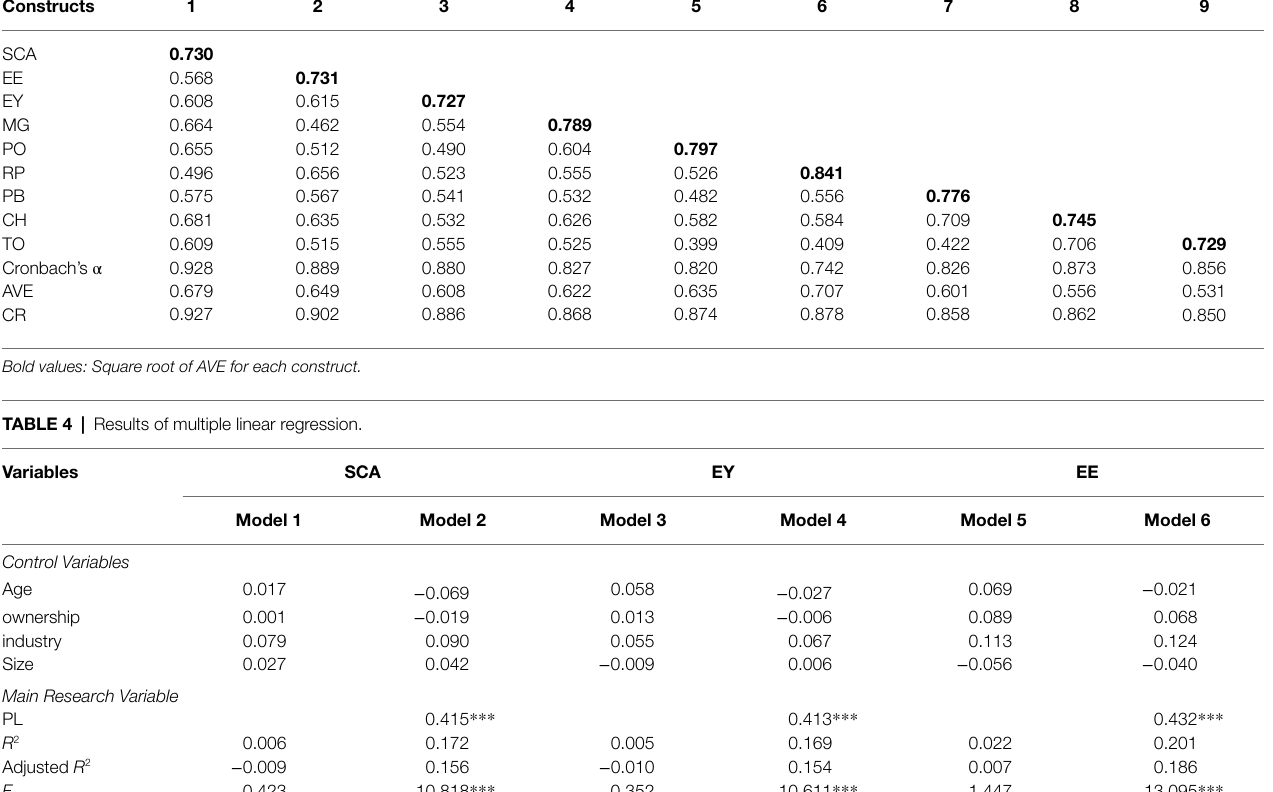
TABLE 3 | Convergent and discriminant validity. Constructs